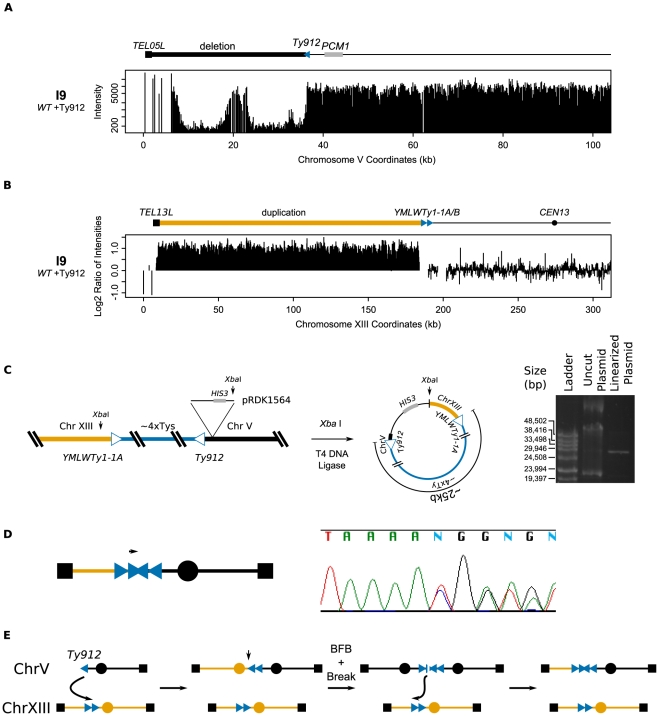
Analysis of isolate I9 reveals a structure consistent with breakage-fusion-bridge.A. Deletion of the region between TEL05L and Ty912 in isolate I9. B. Duplication of the genomic region between TEL13L and YMLWTy1-1A/B. The duplicated region is located upstream of the 5′ end of YMLWTy1-1A/B as indicated. C. Schematic of the integration of pRDK1564 near the fusion junction and the subsequent steps utilized to create a vector cloning the fusion junction. The linearized form of the vector measures approximately 30 kb; 25 kb of the cloned fusion vector is predicted to be Ty DNA. D. Internal primer hybridizing within the epsilon sequence of the Ty reveals a heterogeneous chromatogram, indicating presence of at least two unique Ty sequences. E. A proposed mechanism for the creation of the observed structure. Exposed Ty912 sequence invades YMLWTy1-1A, resulting in a dicentric chromosome. Formation of the dicentric results in one round of breakage-fusion-bridge (with the break at the vertical arrow) followed by a subsequent break due to the formation of a second dicentric. The new break invades a wild type copy of chromosome XIII at YMLWTy1-1A/B resulting in the observed duplication and correctly sized fusion junction.